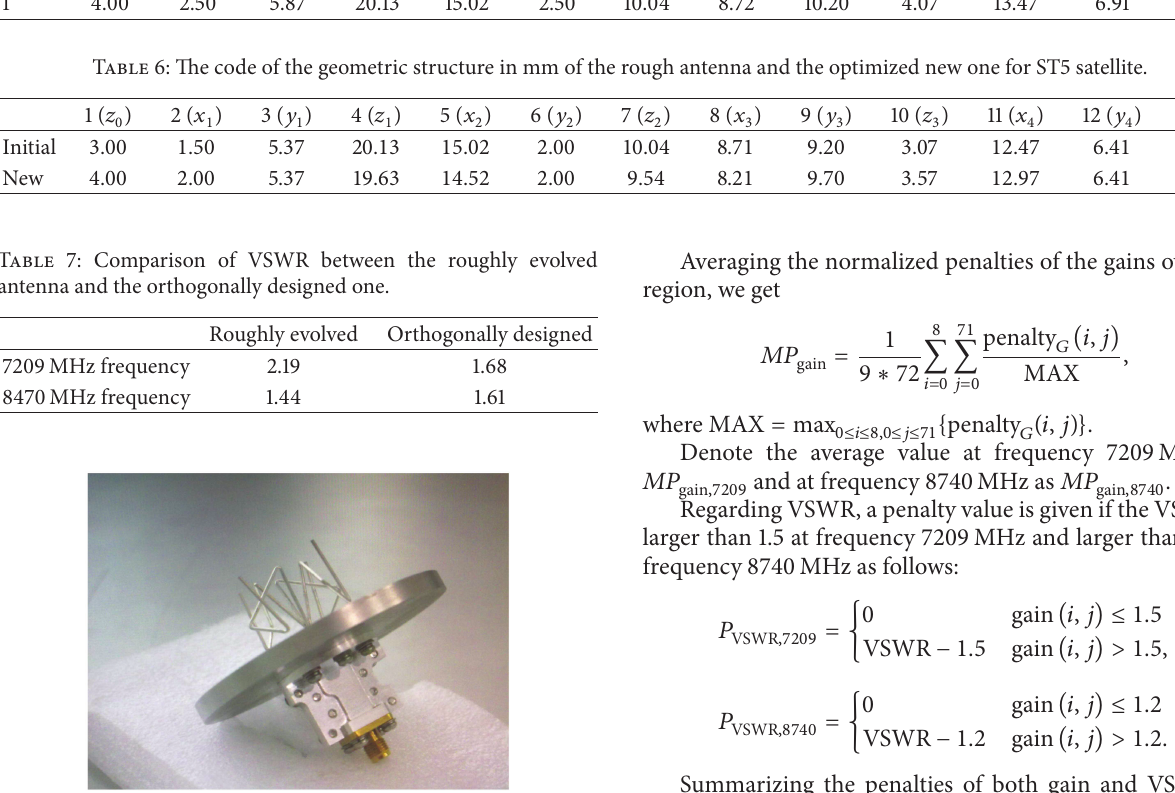
Figure 6: Photograph of prototype of the antenna improved by the OMD